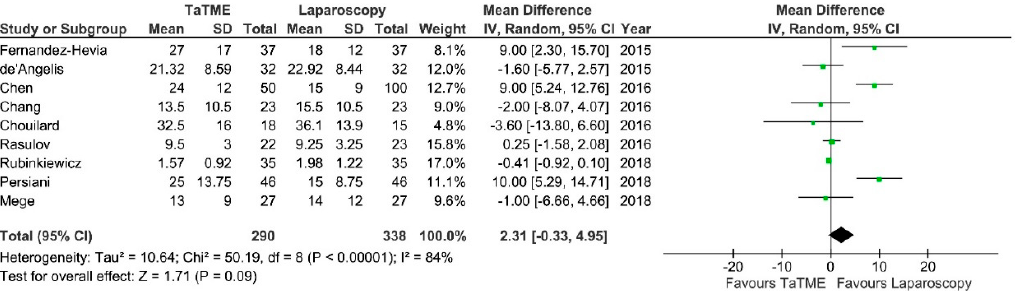
Figure 10. Length of distal resection margin. CI—Confidence Interval; df—degrees of freedom;